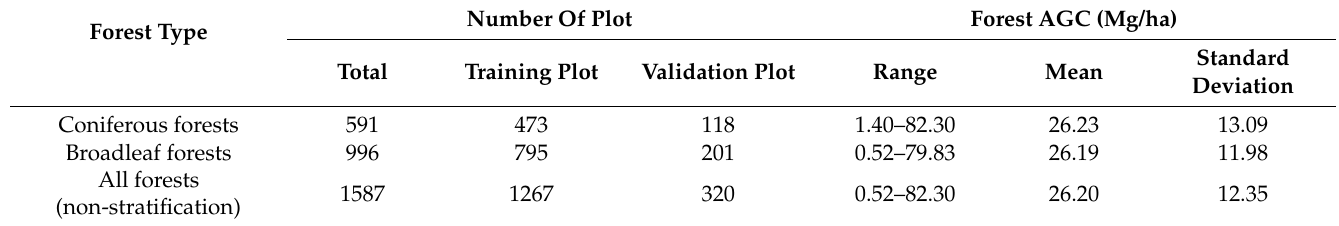
Table 2. Overview and distribution of forest AGC of the forest-type-based stratification sample